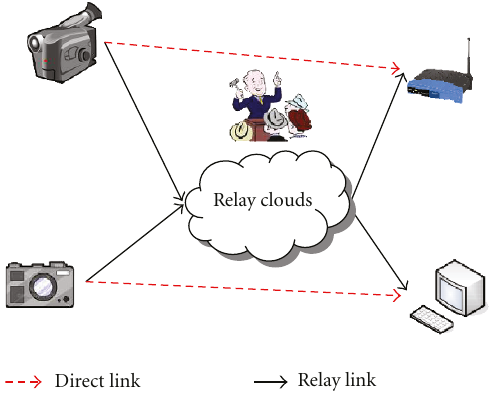
Figure 2: Multiple User Resource Allocation in